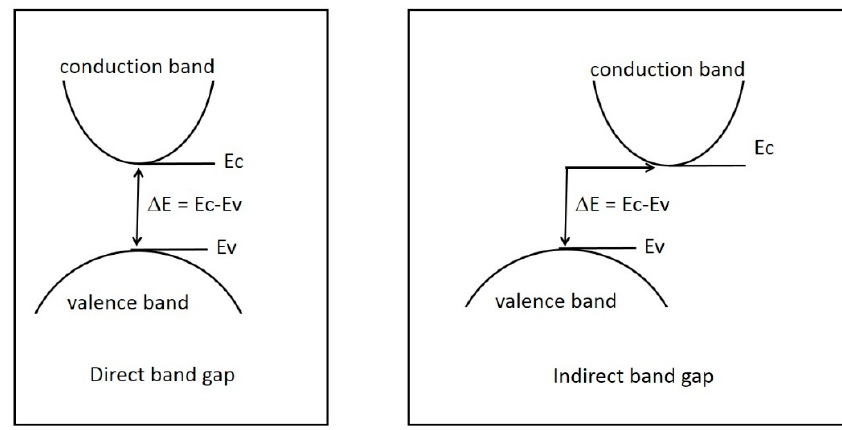
Figure 3. Schematic and simplified representation of direct and indirect optical transition.